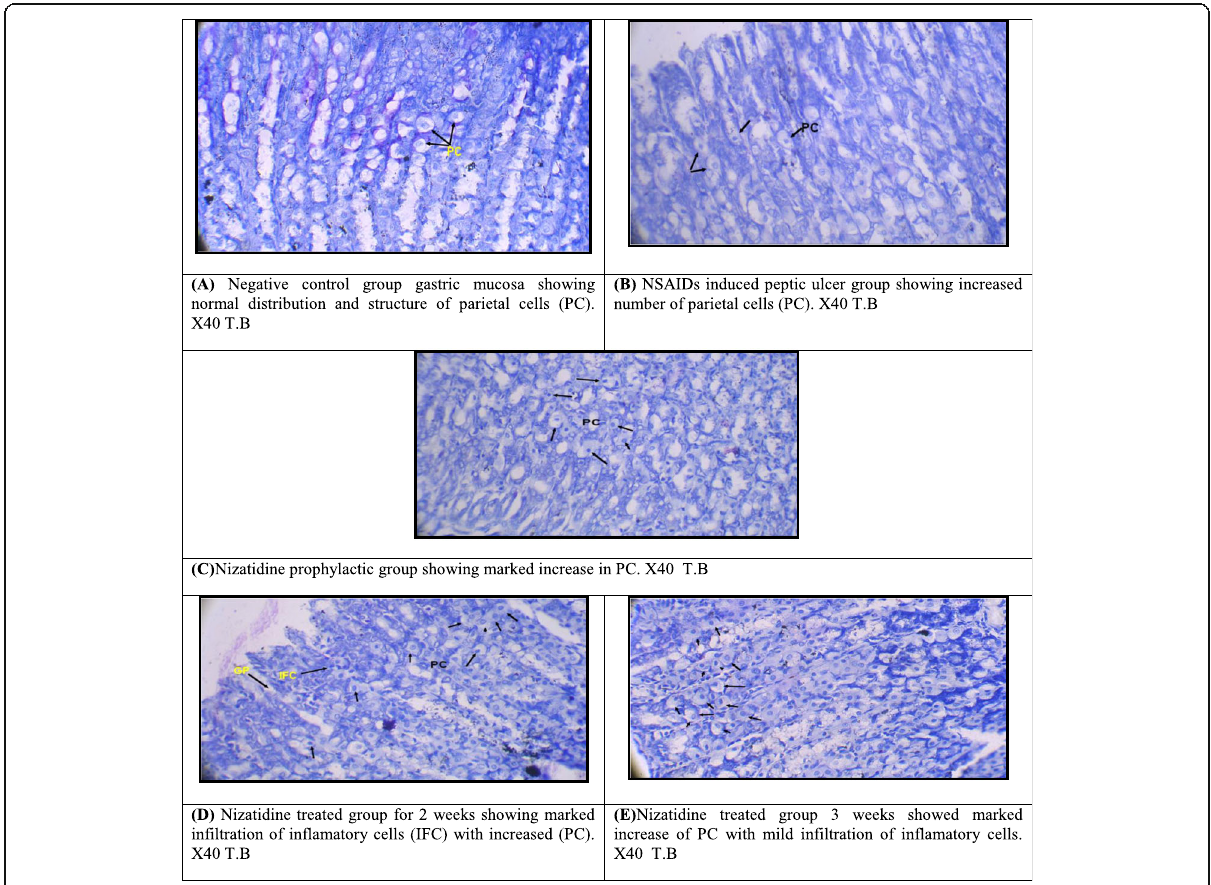
Fig. 5 a Negative control group gastric mucosa showing normal distribution and structure of parietal cells (PC), X40 T.B. b NSAIDs-induced peptic ulcer group showing an increased number of parietal cells (PC), X40 T.B. c Nizatidine prophylactic group showing a marked increase in PC, X40 T.B. d Nizatidine-treated group for 2 weeks showing marked infiltration of inflammatory cells (IFC) with increased (PC), X40 T.B. e Nizatidine- treated group 3 weeks showed marked increase of PC with mild infiltration of inflammatory cells, X40